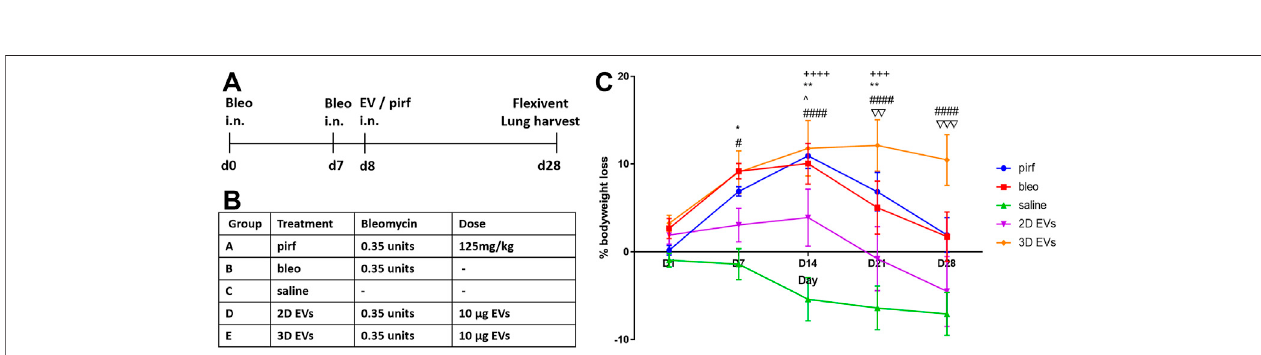
FIGURE 4 | Testing 2D and 3D EVs using an in vivo lung fi brosis model with double hit bleomycin in aged mice. (A) Timeline for the administration of double hit bleomycinandEV/pirfenidoneandendpoint. (B) Descriptionofexperimentalgroupsandthetreatmentdose. (C) Percentageofbodyweightlossinagedmicethroughout the28 days.Two-wayANOVAwasusedfollowedbyTukey ’ sposthoctestformultiplecomparisons,* p < 0.05,** p < 0.01,bleovssaline,# p < 0.05,#### p < 0.00013D EVs vs. saline, +++ p < 0.001, ++++ p < 0.0001 pirf vs saline, ^ p < 0.05 2D EVs vs saline, ∇∇ p < 0.01 2D EVs vs 3D EVs, ∇∇∇ p < 0.001 2D EVs vs 3D EVs.